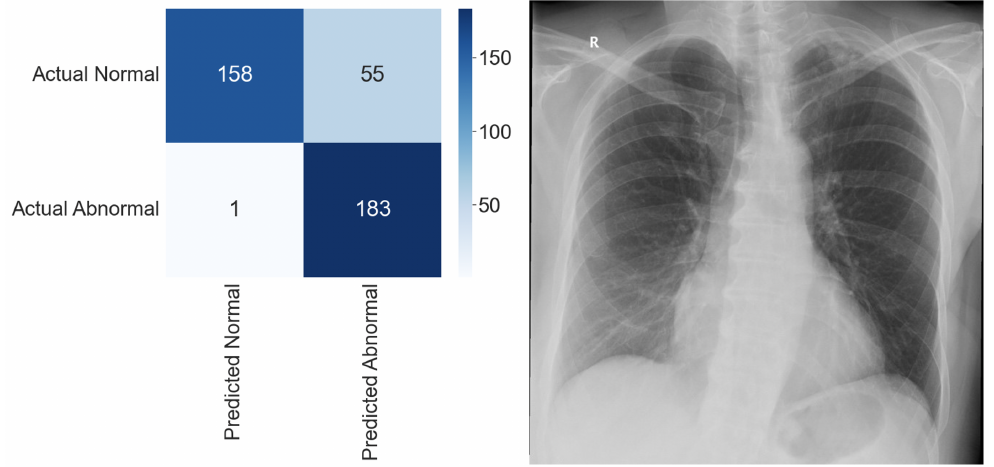
Figure 2. Confusion matrix and a false negative image that DLAD incorrectly classified as a true negative during the internal test. The CXR scan in high quality can be found in the Appendix A (Figure A1).